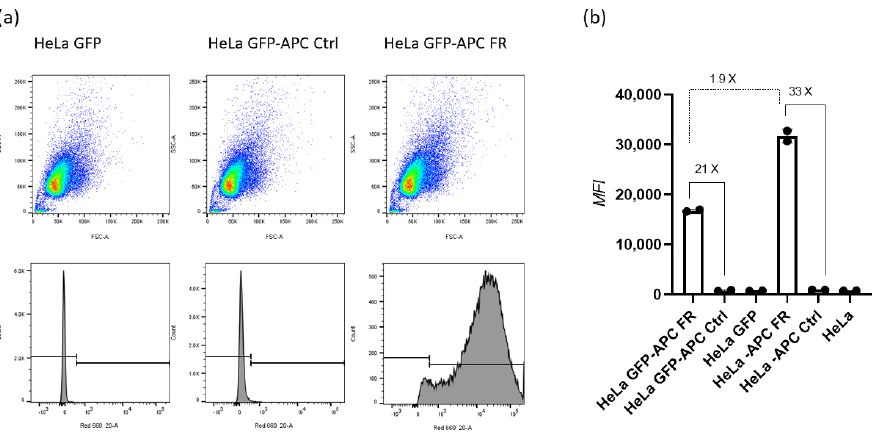
Figure 1. Relative expression levels of cell-surface folate-binding proteins (receptor) in HeLa and HeLa GFP cells expressing green fluorescent protein (GFP). ( a ) determined by flow cytometry; ( b ) median fluorescence intensity; APC FR represents allophycocyanin-labeled antibody against anti-human Folate Receptors alpha and beta, while APC Ctrl represents a allophycocyanin labeled Rat IgG2a, Ctrl antibody (kappa isotype).